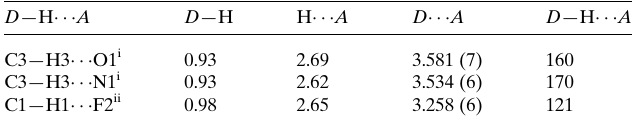
Table 1 Hydrogen-bond geometry (A˚ , (cid:6)